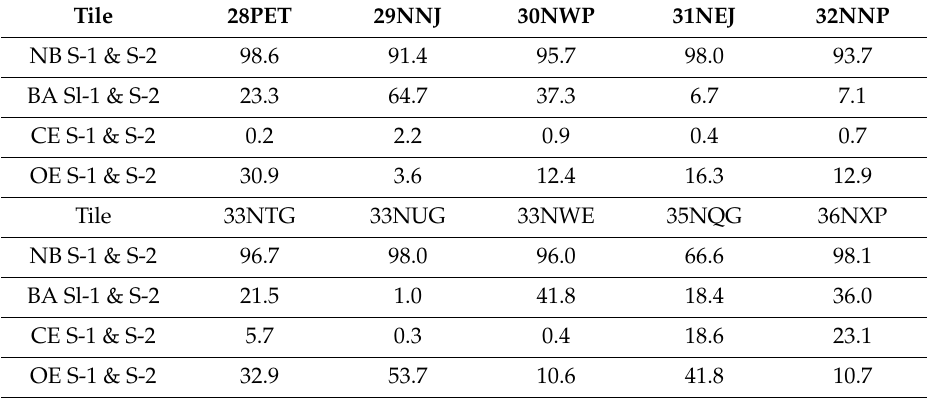
Table 5. Spatial agreement (%) between detections from Sentinel-1 (RtsB) and Sentinel-2 (Ots) based algorithms (NB–not burned, BA–burned area, CE–commission errors, OE–omission